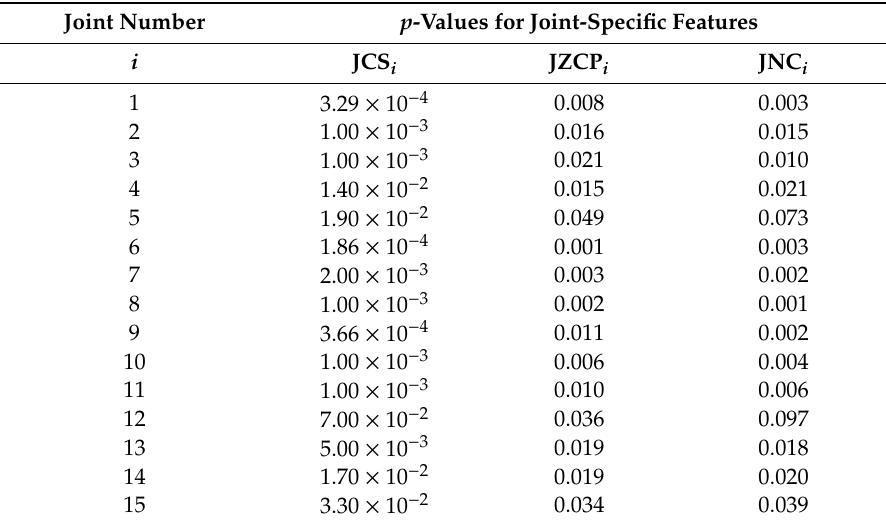
Figure 7. Summary of the joint-specific NC features (JNC i , i = 1, …, 15) of both age groups. Table 2. Summary of the p -values of joint-specific features. Joint Number p -Values for Joint-Specific